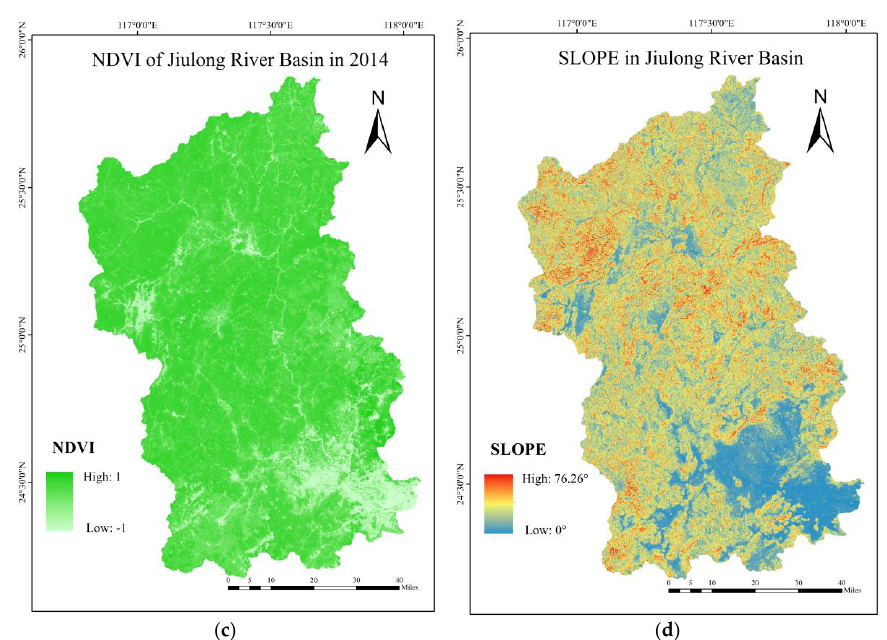
Figure 4. The geographical factors for the index calculation. ( a ) digital elevation model (DEM) in Jiulong River basin; ( b ) The effective distance in 2017; ( c ) normalized difference vegetation index (NDVI) in 2014; ( d ) Slope data of Jiulong River